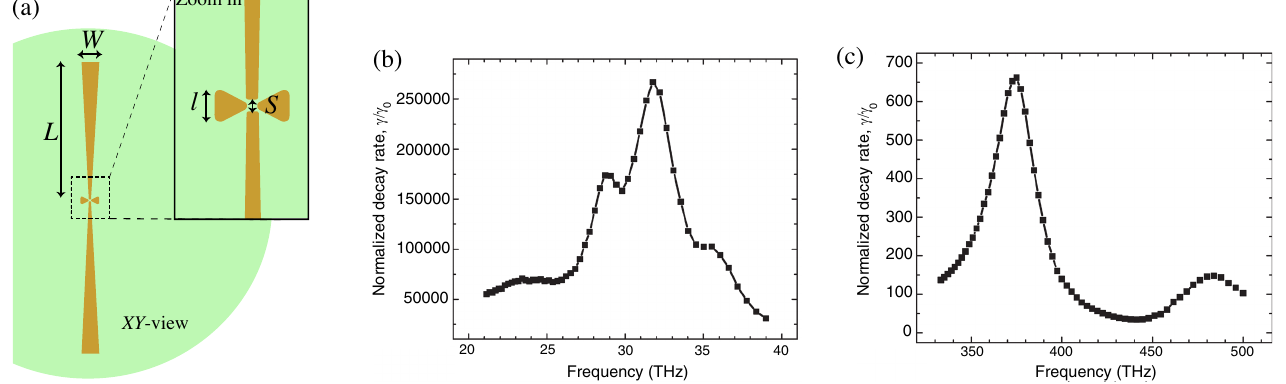
FIG. 6. (a) Geometry of the dual antenna considered in our manuscript. The parameters W ¼ 70 nm, L ¼ 2 . 25 μ m, l ¼ 90 nm, and S ¼ 25 nm are used to run the numerical simulations and evaluate the performance of our conversion scheme. The antenna edges are rounded with 4 and 1.3 nm radii of curvature for the optical and IR antenna, respectively. (b),(c) Normalized decay rate of an emitter placed at the center of the dual antenna in the mid-IR (b) and in the visible range (c).